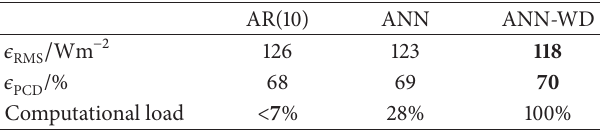
Table 1: Results concerning the sixty-step ahead solar radiation prediction over validation